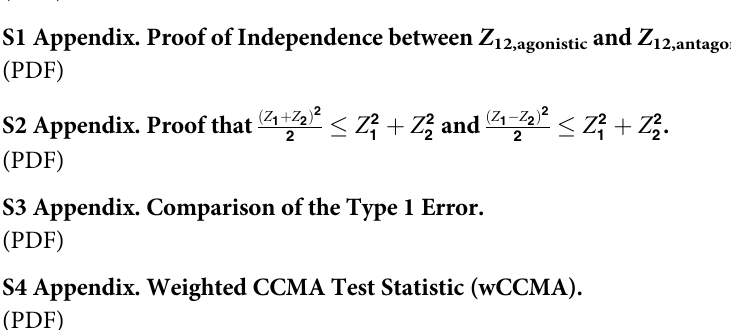
S5 Fig. Simulation-based type 1 error comparison of CCMA, wCCMA and the Subset- Based Meta-Analysis (ASSET) under H . We ran R = 100,000 simulations with n = 8,000 0 . Several significance thresholds were considered individuals for various MAF values under H 0 for comparison α = (0.001, 0.005, 0.01, 0.05). S1 Table. Type 1 error comparison of CCMA, wCCMA and the Subset-Based Meta-Analy- . We ran R = 100,000 simulations with n = 8,000 individuals for various sis (ASSET) under H 0 . Several significance thresholds were considered for comparison α = (0.001, MAF under H 0 0.005, 0.01, 0.05). S2 Table. Power comparison of the CCMA, wCCMA and Subset-Based Meta-Analysis (ASSET) for detection of true associations at a significance level of α = 0.001 and α = 10 − 5 . For each power estimate, we ran R = 1,000 simulations with n = 8,000 individuals for various MAF and OR values and assigned the disease status by a multinomial model and distributed controls equally to both case sets. S3 Table. Power comparison of the CCMA, wCCMA and Subset-Based Meta-Analysis (ASSET) for detection of true associations at a significance level of α = 0.001 and α = 10 − 5 . For each power estimate, we ran R = 1,000 simulations with n = 8,000 individuals for various MAF and OR values and assigned the disease status by a multinomial model and distributed controls proportionally to the case